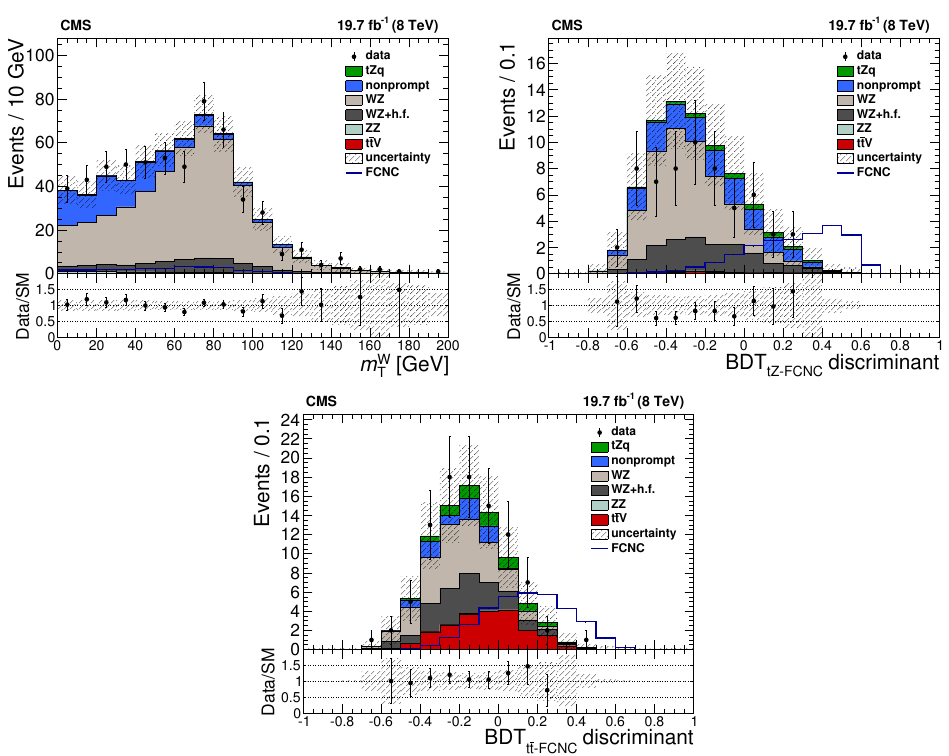
Figure 5 . Data-to-prediction comparisons for the tZ-FCNC search after performing the (cid:12)t for m W distribution in the control region (top-left), and for the BDT responses in the single top quark T (BDT tZ-FCNC ) (top-right), and tt (BDT ) (bottom), signal regions. An example of the pre- tt-FCNC dicted signal contribution for a value B (t ! Zu) = 0 : 1% (FCNC) is shown for illustration. The four channels are combined. The lower panels show the ratio between observed and predicted yields, including the total uncertainty on the